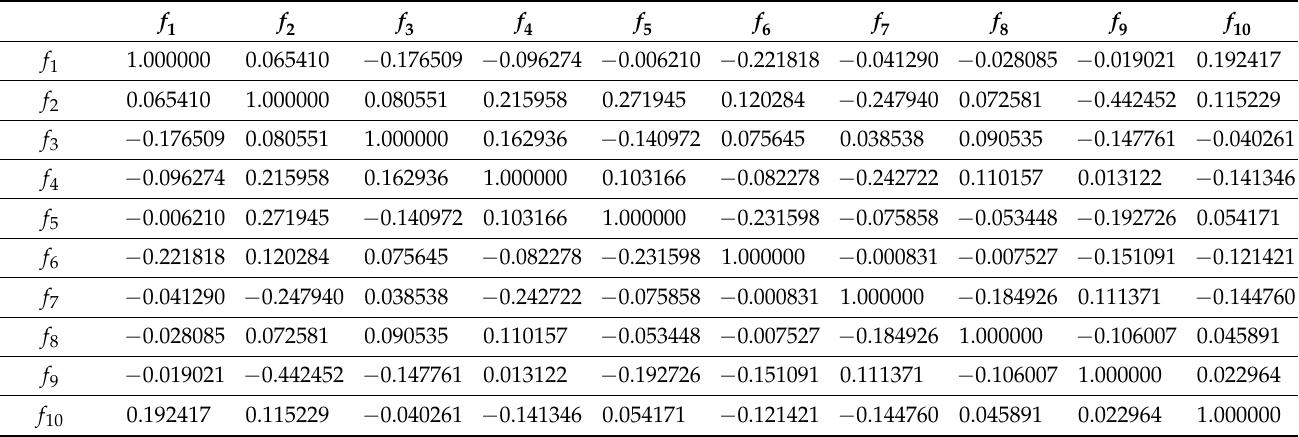
Table 3. Correlation values of the dataset.